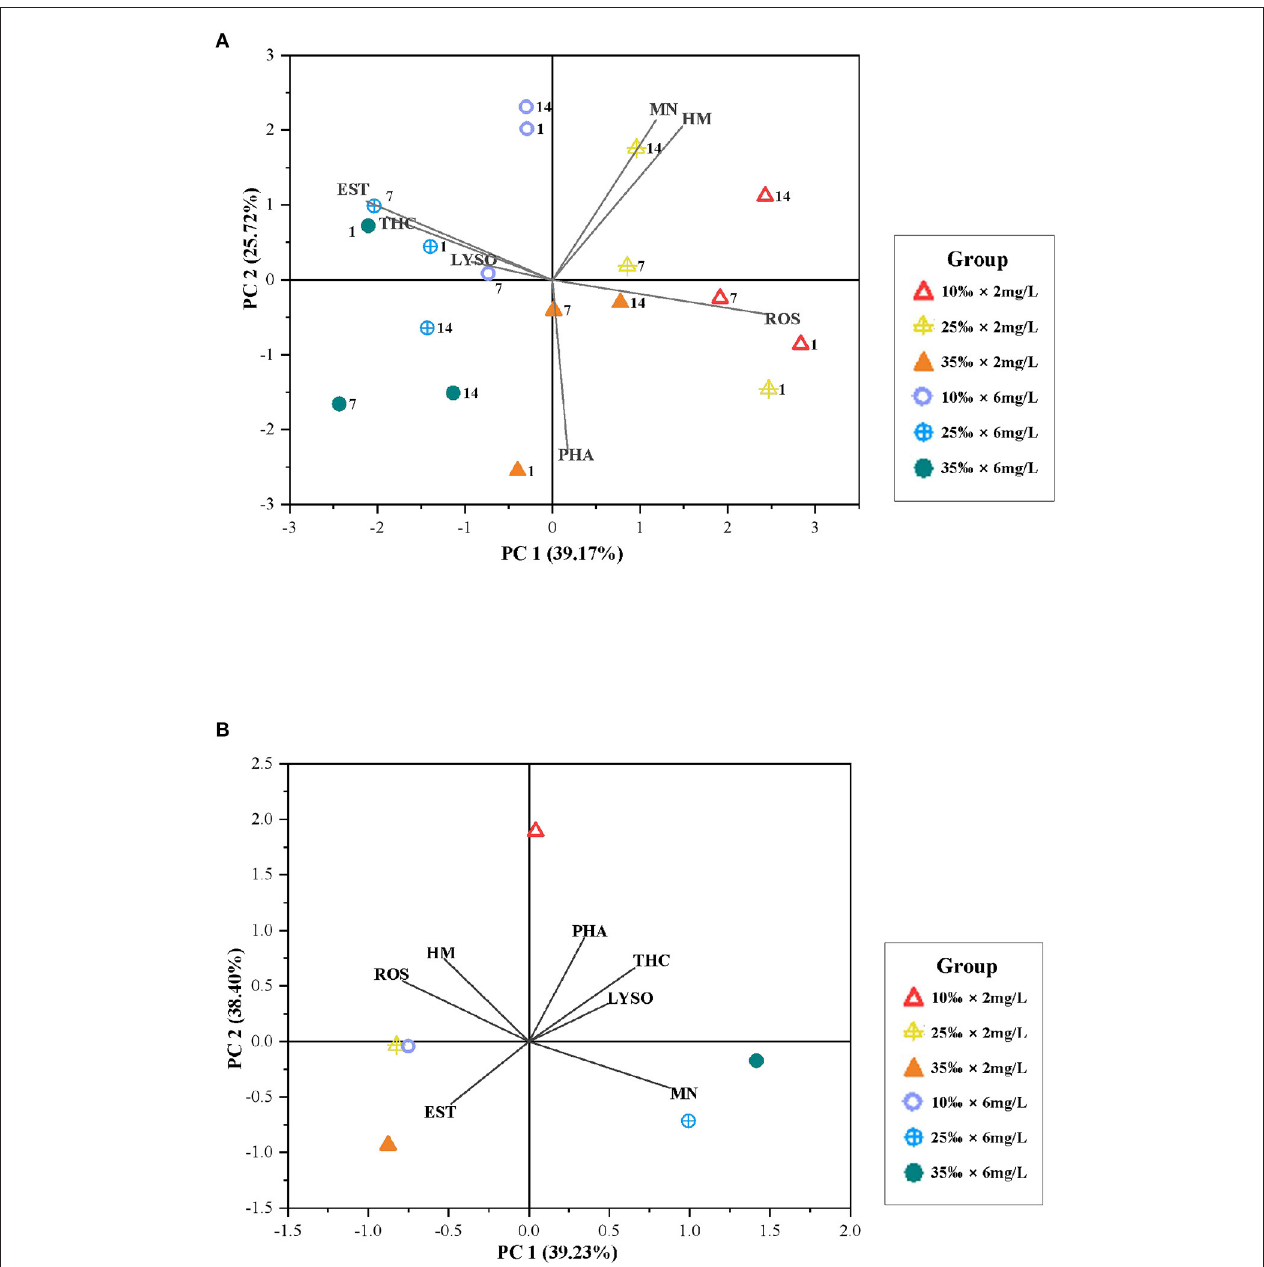
FIGURE 8 | (A) Biplot originating from PCA integrating all measured variables (HM, PHA, EST, ROS, THC, LYSO, and MN) and three time points (days: 1, 7, and 14) at six different treatments during the exposure period. (B) Biplot originating from principal component analysis integrating all measured variables (HM, PHA, EST, ROS, THC, LYSO, and MN) at six different treatments after the 3-day recovery. The scores of the experimental conditions were shown.